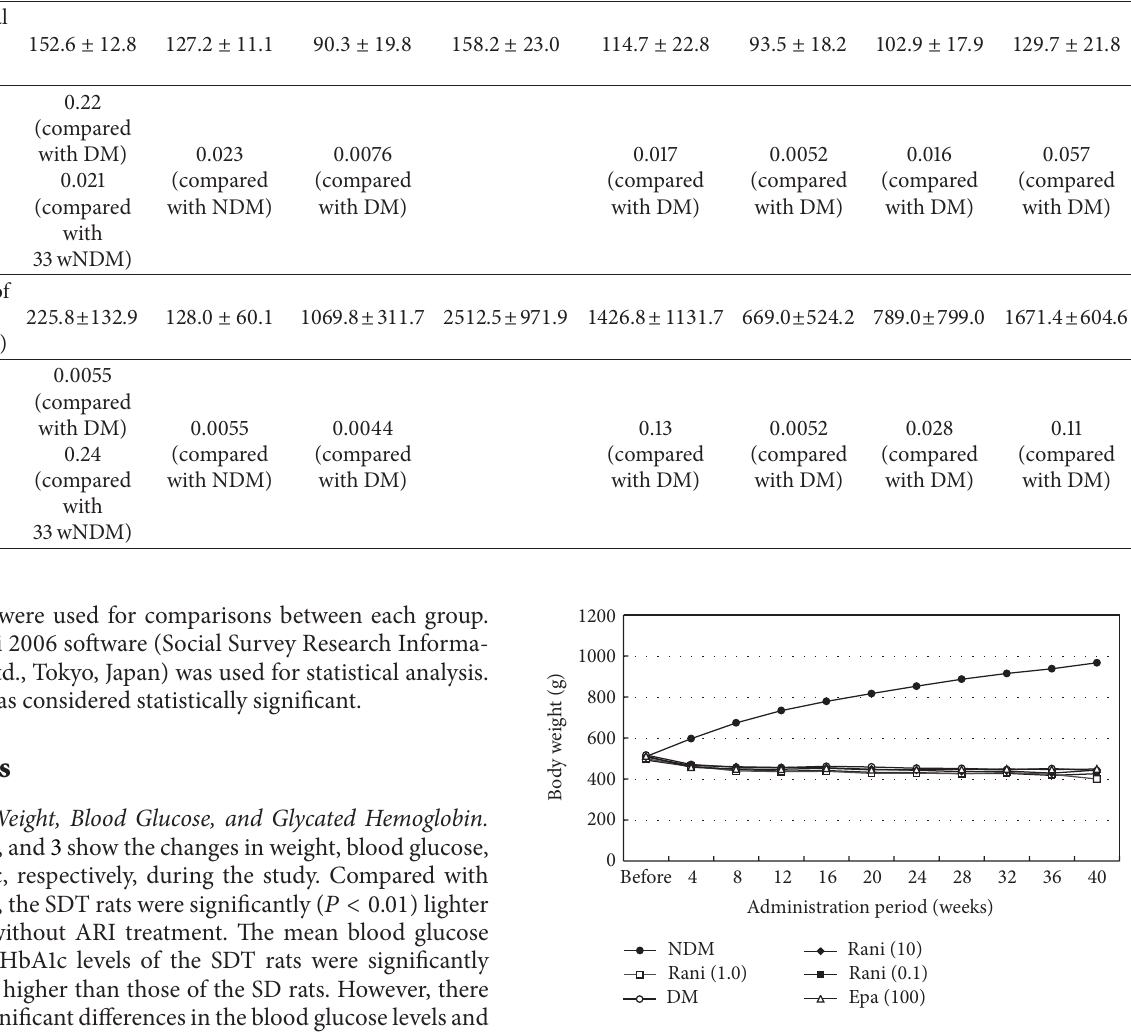
Figure 1: Body weight of the study animals. The SD rats are heavier than the SDT rats with or without treatment. NDM: normal SD rats; DM: untreated SDT rats; rani (0.1): ranirestat-treated SDT rats (0.1mg/kg/day); rani (1.0): ranirestat- treated SDT rats (1.0mg/kg/day); rani (10): ranirestat-treated SDT rats (10mg/kg/day); epa (100): epalrestat-treated SDT rats (100mg/kg/day)